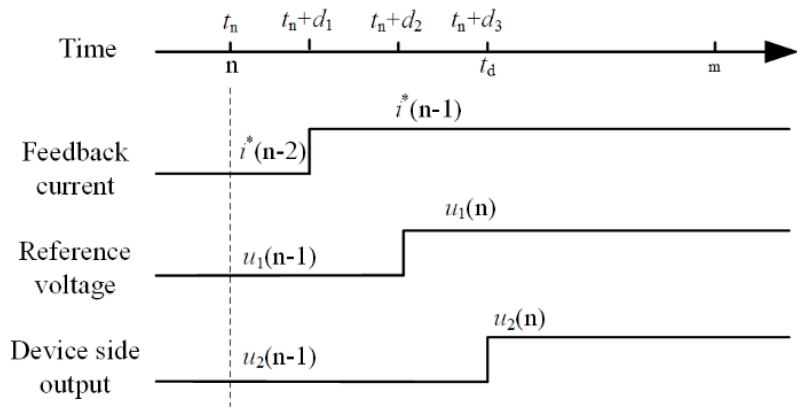
Figure 3. The sequential control logic diagram of the new IA.